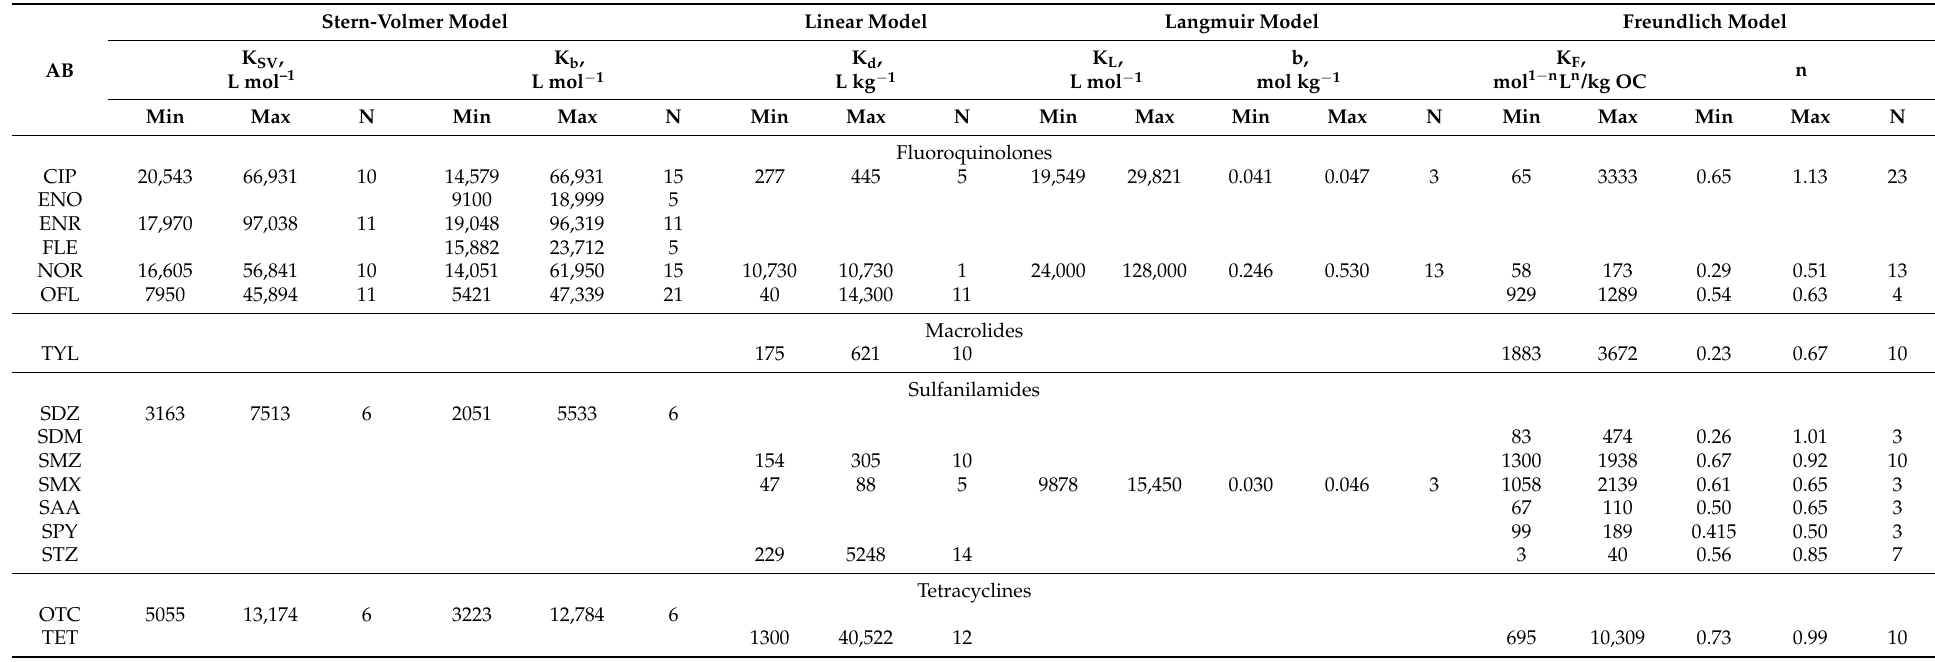
Table 4. The calculated range of the binding constants of antibiotics to HS measured by different